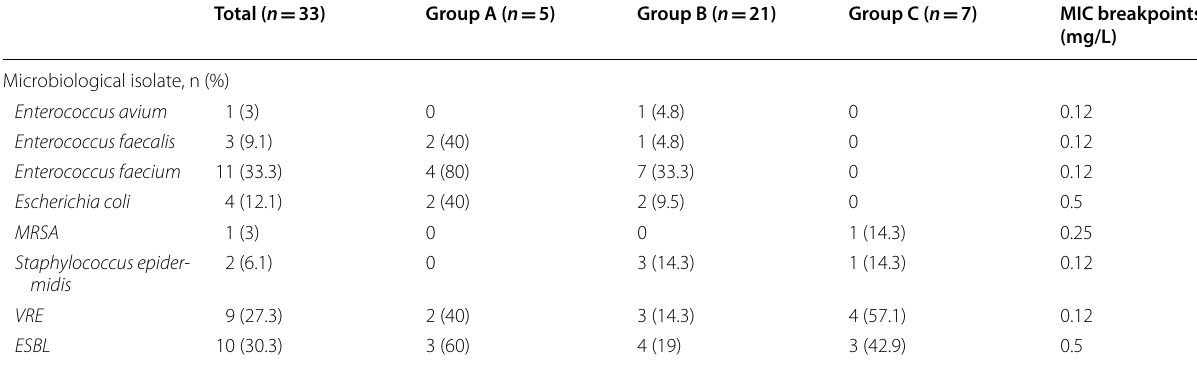
MRSA: methicillin-resistant Staphylococcus aureus ; VRE: vancomycin-resistant Enterococci; ESBL: extended betalactamase producing Gram-negative bacteria; MIC: minimum inhibitory